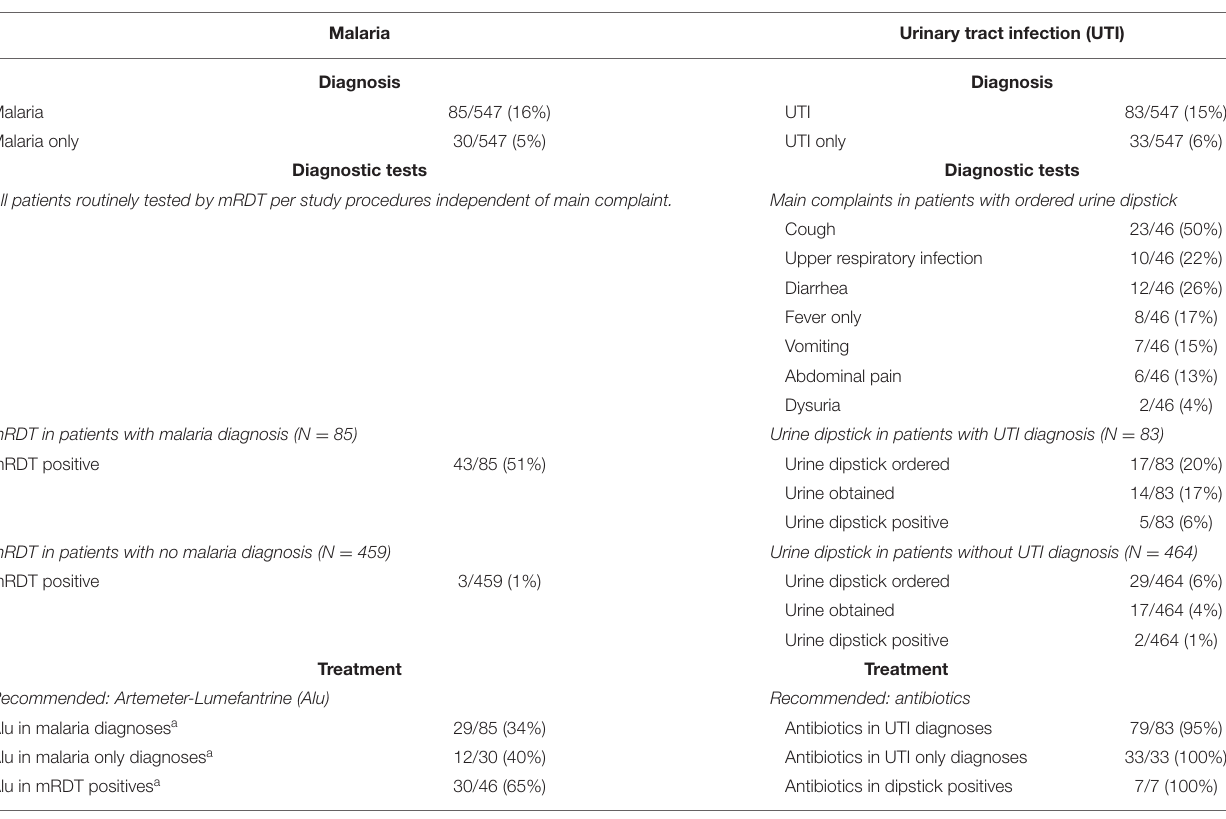
TABLE 3 | Compliance to recommended diagnostic